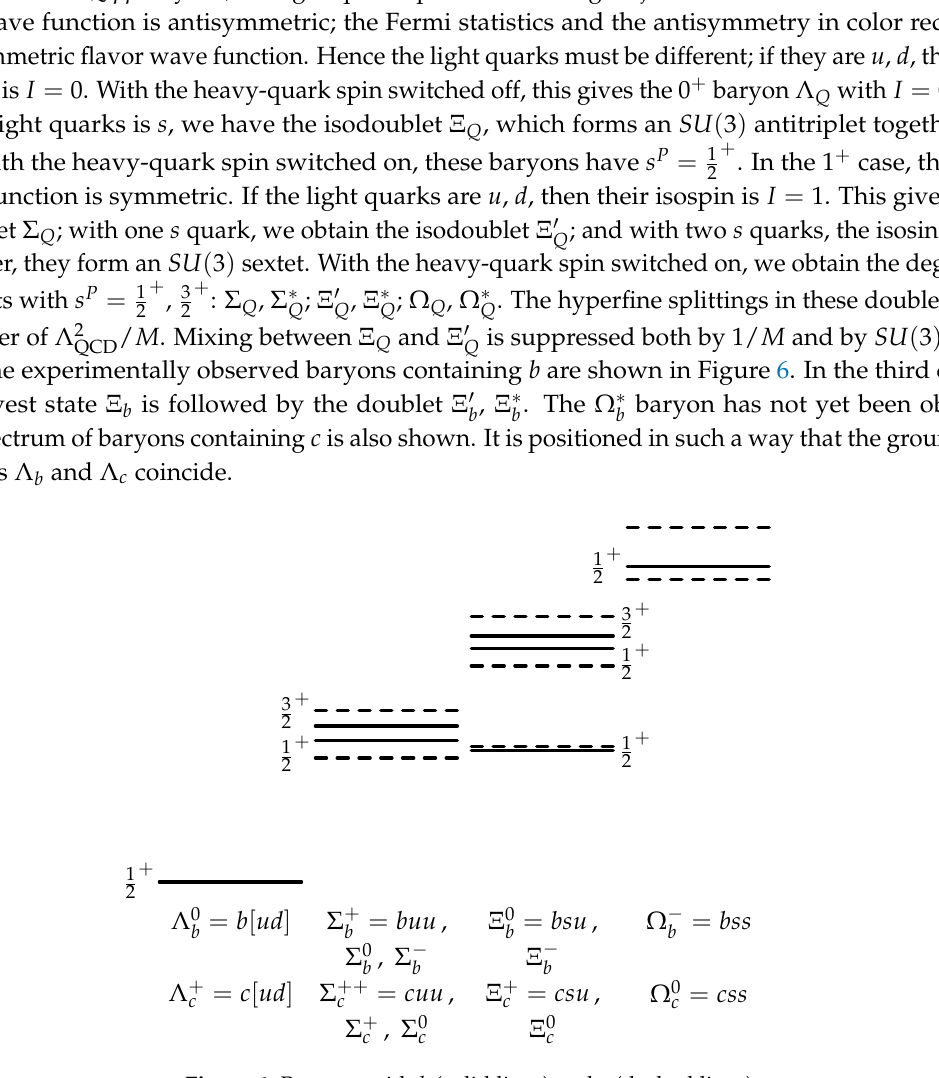
Figure 6. Baryons with b (solid lines) and c (dashed